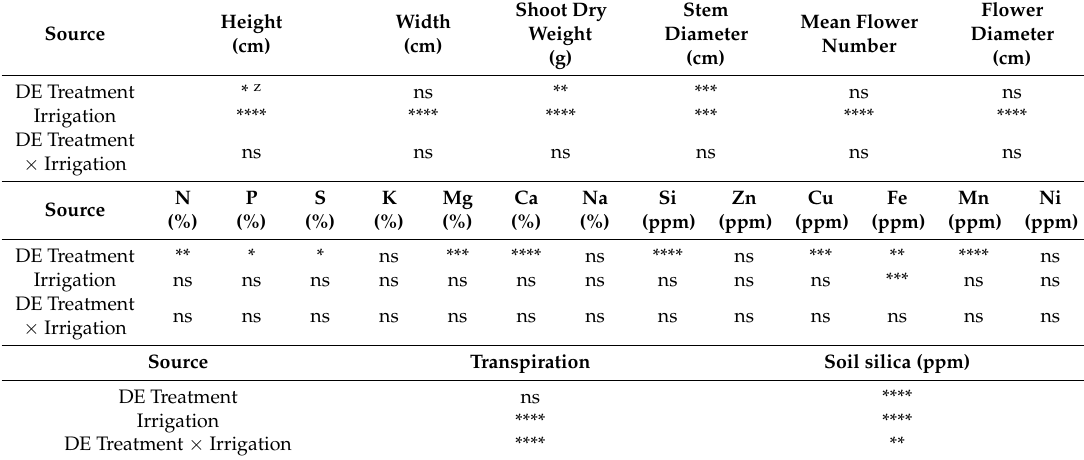
Table 1. Analysis of variance for growth, flowering, leaf nutrient content, soil silica, and physiology of Dahlia × hybrida ‘Dahlinova Montana’ after application of diatomaceous earth (DE) and irrigation controlled with a